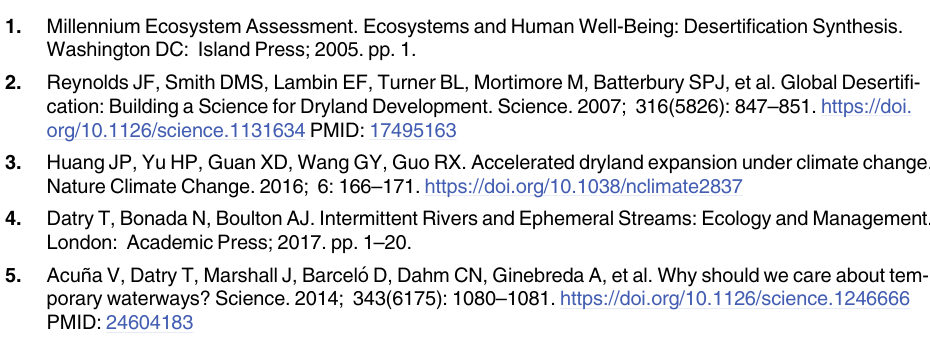
S1 Table. Information on the Landsat imagery